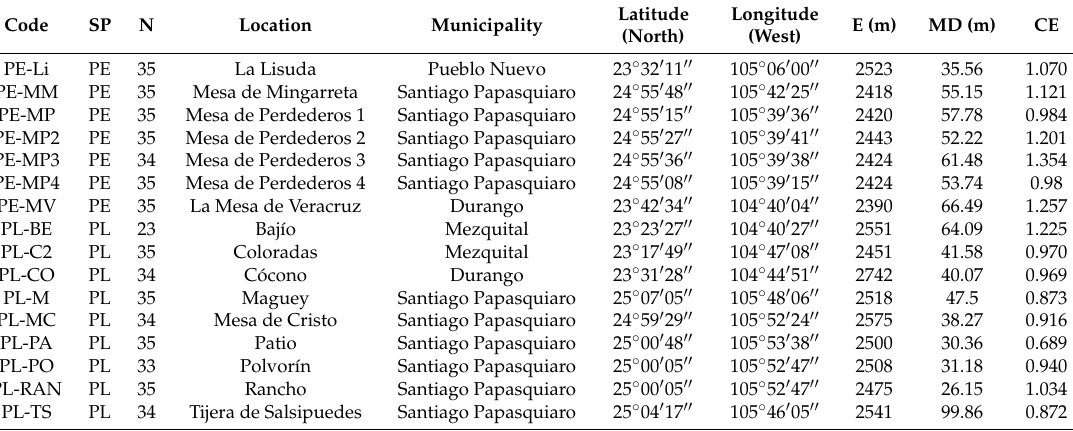
Table 1. Location, and some characteristics (sample size (N), elevation (E), mean distance between the trees (MD), Clark and Evans (1954) aggregation index (CE)) of the seven seed stands of Pinus engelmannii and nine seed stands of P. leiophylla under study in the Sierra Madre Occidental, Durango,